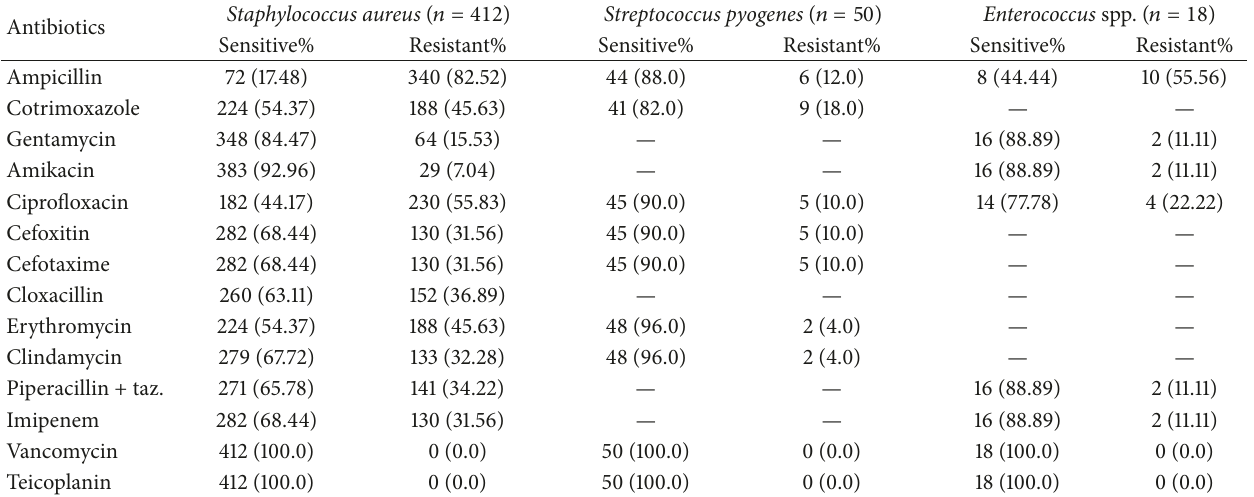
Table 2: Antibiogram of Gram positive